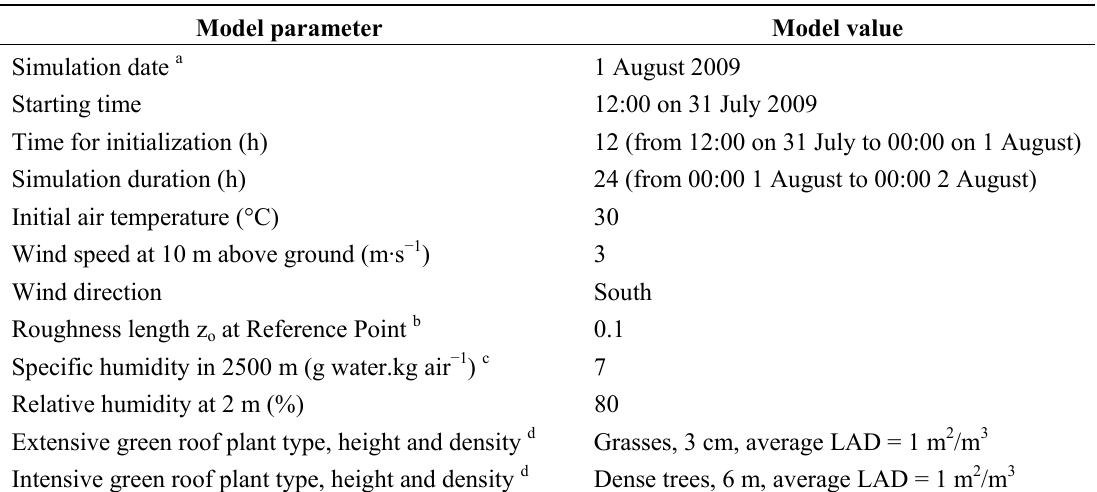
Table 2. Model input data for the ENVI-met